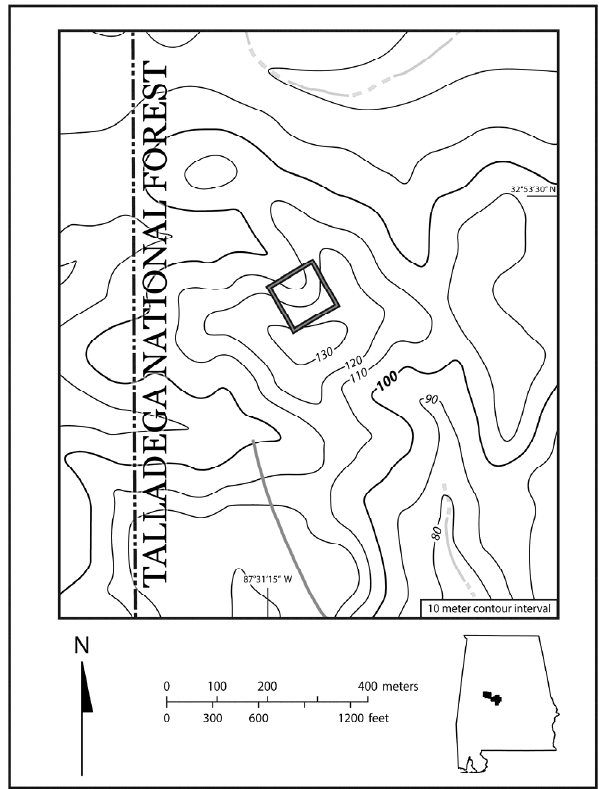
Figure 1. Map of the study site within the Oakmulgee Ranger District of the Talladega National Forest. The square represents the 1 ha study plot. The shaded area within the Alabama inset map represents the Oakmulgee Ranger District.